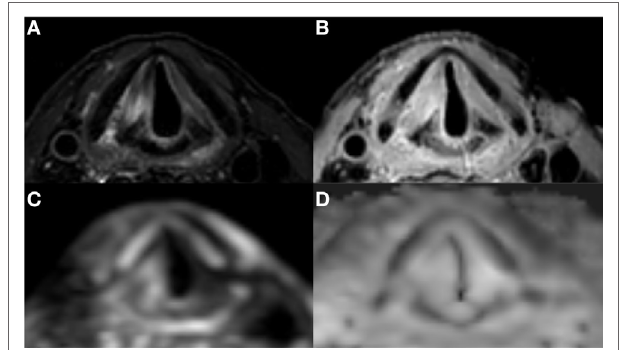
FIgURe 7 | Laryngeal magnetic resonance imaging of a patient with superficial recurrence after radiotherapy of an early glottis carcinoma: high signal intensity in the right vocal cord and posterior paraglottic space on T2 (A) combined with a high signal intensity on both DWI (c) and ADC (D) is compatible with post irradiation edema and rules out deep tumor extension. There is diffuse enhancement on contrast enhanced T1 with fat suppression (B)